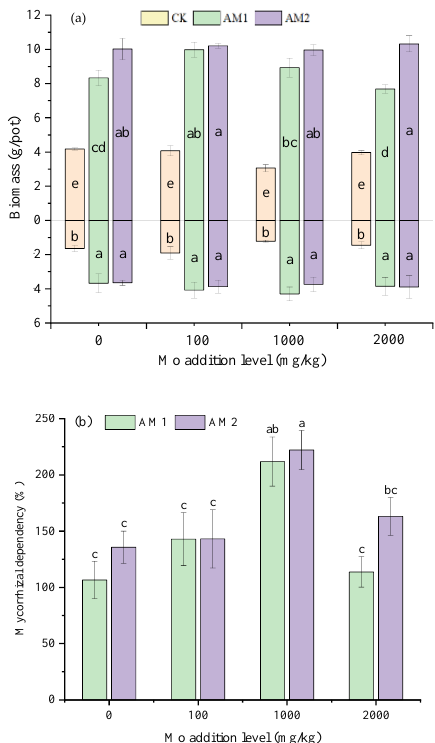
Figure 1. Shoot (above X -axis) and root (below X -axis) dry weight of maize plants and ( a ) mycorrhizal dependency (means ± SE, n = 4) ( b ) of maize at different levels of Mo addition. Different lowercase letters above the bars indicate significant differences under the different inoculation conditions among different levels of Mo addition, determined using a one-way ANOVA followed by Duncan’s multiple range test ( p < 0.05).